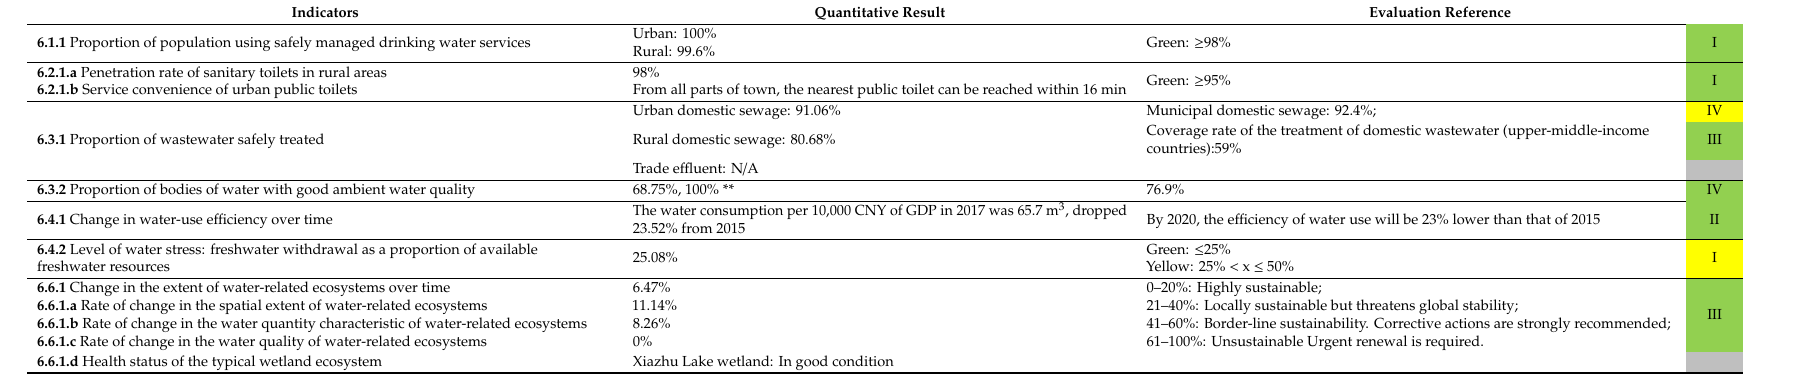
Table 3. Calculating and ranking SDG 6